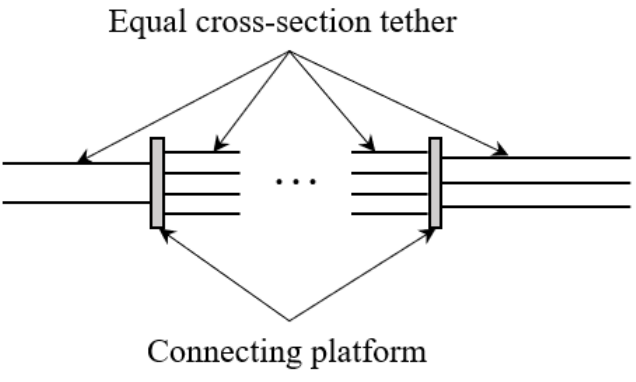
Figure 2. Detailed structure of segmented space elevator system